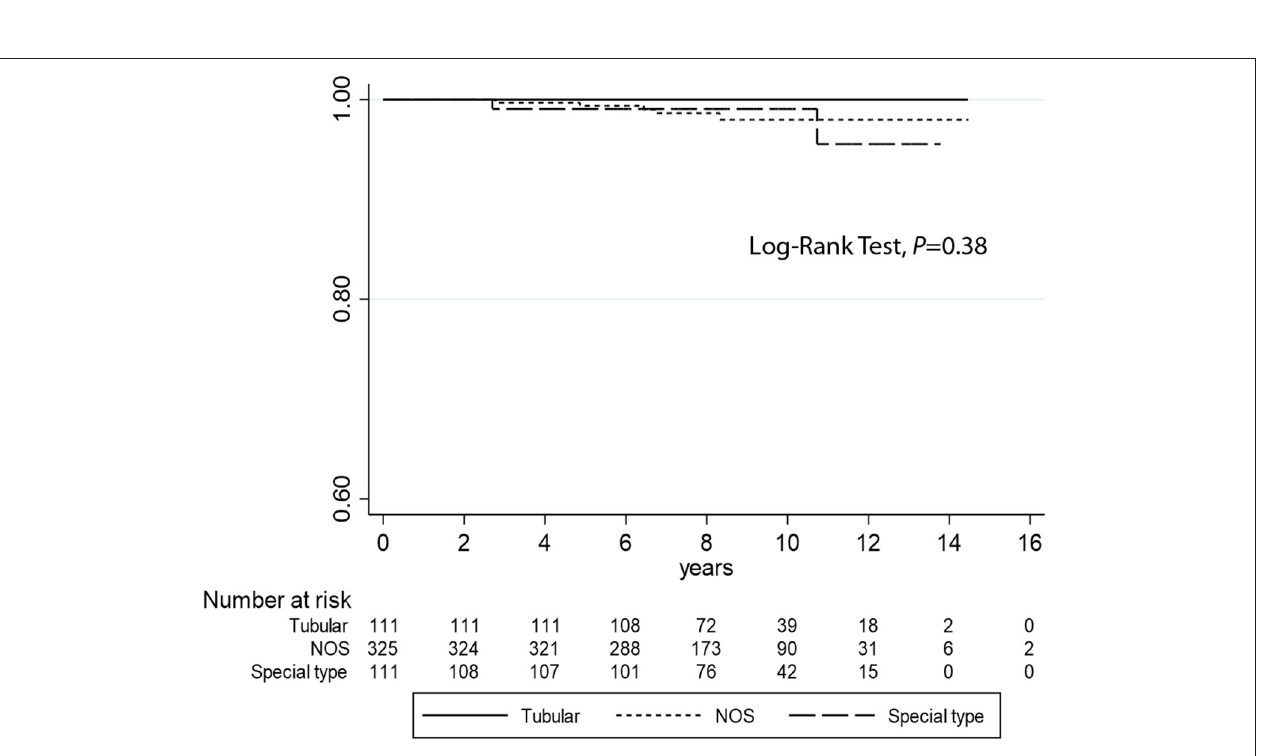
Frontiers in Oncology |